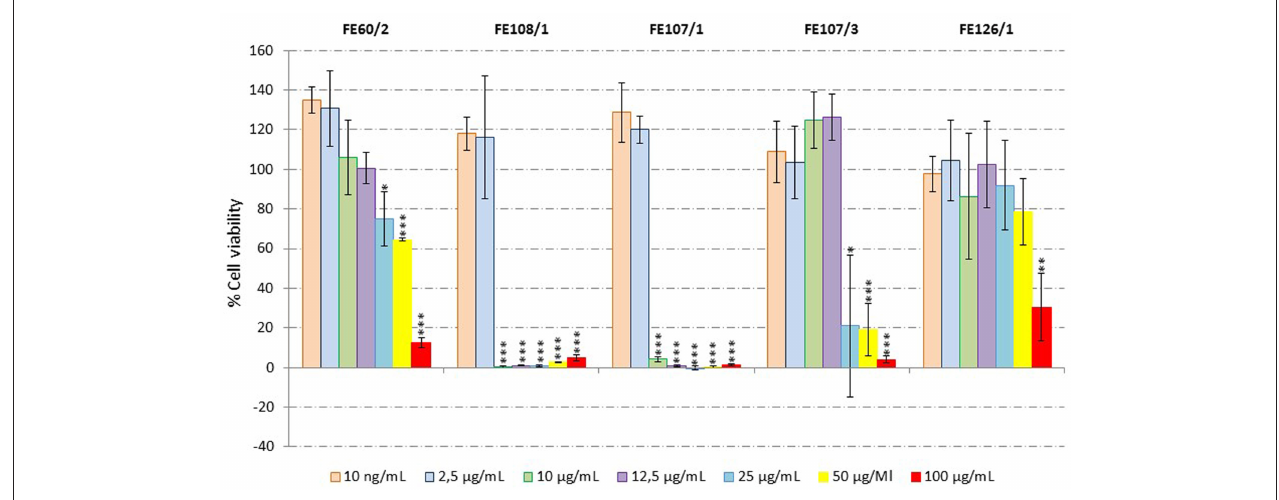
FIGURE 3 | Anticancer Assay. Percentage viability of human melanoma cells (A2058) after incubation for 72h with microalgal extracts ( Skeletonema marinoi FE60/2, Alexandrium andersoni FE108/1, Alexandrium tamutum FE107/1 and FE107/3, and Alexandrium minutum FE126/1) at 100, 50, 25, 12.5, 10, and 2.5 µ g/mL and 10ng/mL ( n = 9, data represent means for three biological and nine technical triplicates; * for p < 0.05, ** for p < 0.01 and *** for p < 0.001, Student’s t -test) compared to control.